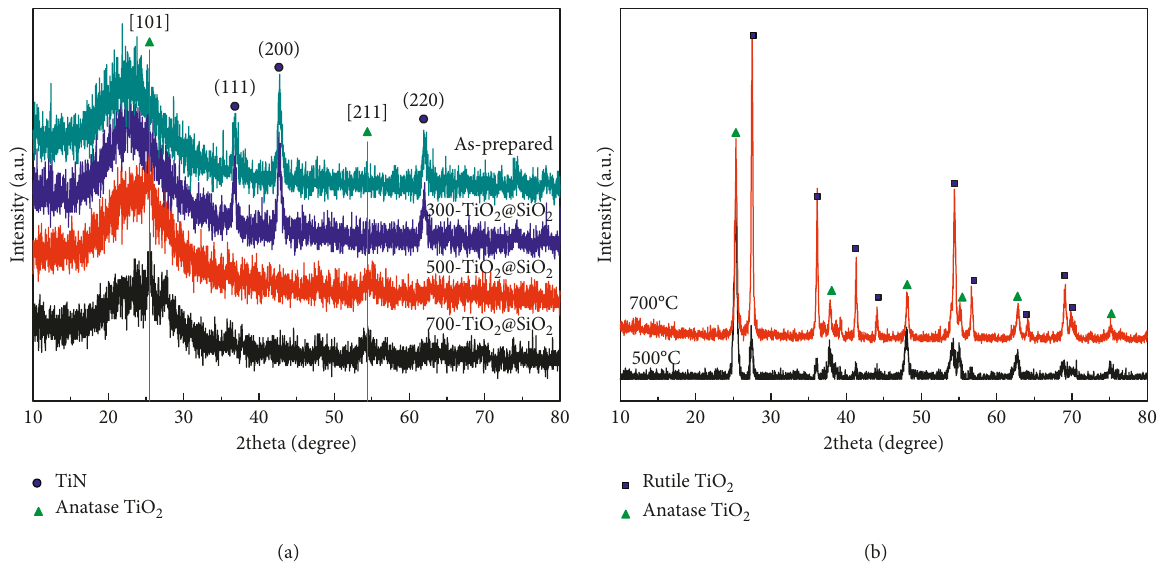
Figure 4: XRD patterns of TiN@SiO 2 composite aerogels (a) and TiN powers with different oxidation temperatures (b).